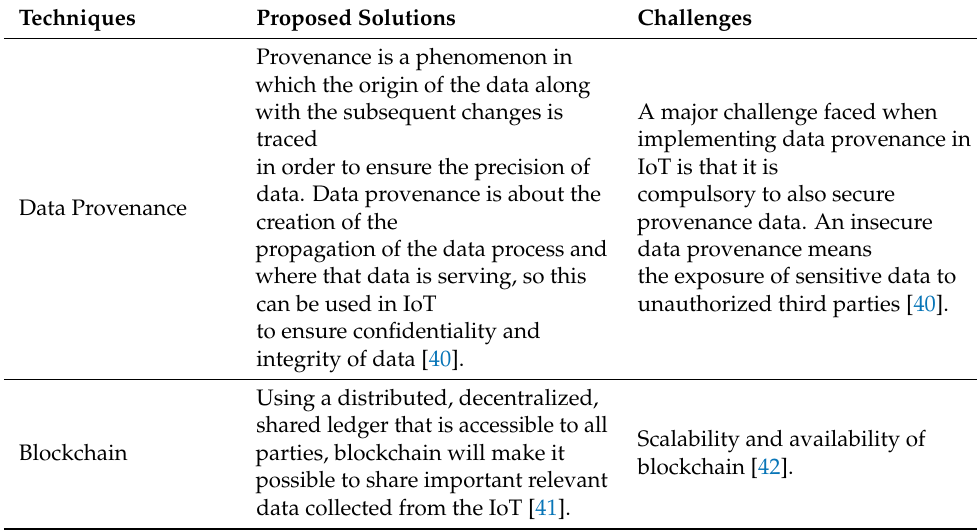
Table 3. Past and recent proposed IoT security solutions and their